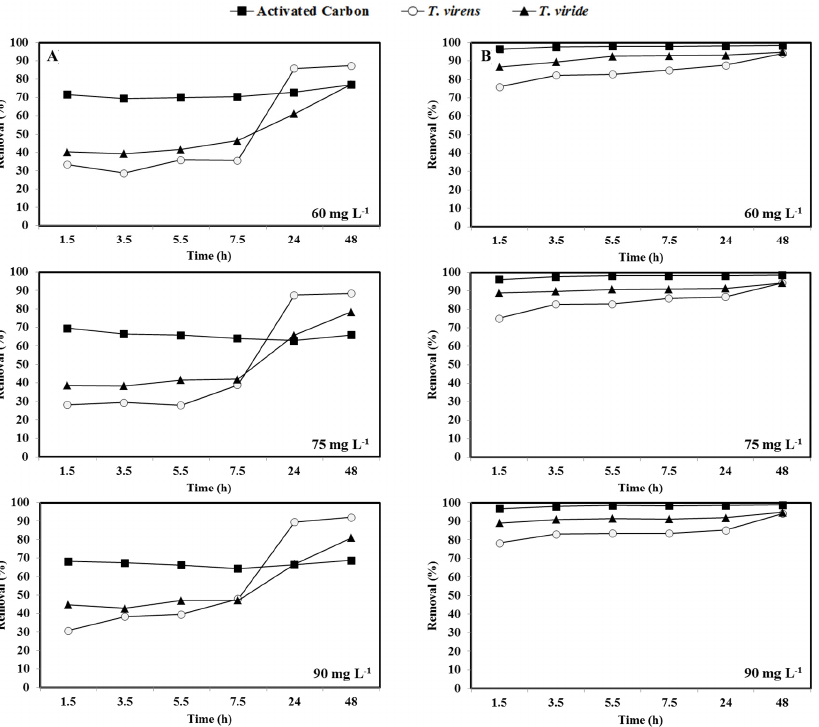
Figure 4. Removal efficiency of Congo red (row A ) and malachite green (row B ) (60, 75, and 90 mg L − 1 ) by activated carbon and fungal dry biomass of T. virens and T. viride . On the other hand, after 24 h, the dry biomass of both Trichoderma species showed higher CR removal capacity than activated carbon (Figure 4A). In addition, the CR re- moval obtained by the dry biomass of T. virens (88%) was higher than that reported for the fungus Aspergillus niger (72%) [73]. In contrast, MG removal by the dry biomass of both fungi was lower than that observed by activated carbon during the first 24 h, alt- hough, at 48 h, the removal of MG by the dry fungal biomass was similar to that observed for activated carbon (Figure 4B). Equilibrium adsorptions data of CR and MG onto activated carbon and dry biomass of the two Trichoderma species were analyzed using the Freundlich (Equation (2)) and Langmuir (Equation (3)) adsorption isotherms. The isothermal plots were found to be lin- ear, and the linear correlation coefficients were slightly higher for the Langmuir model (Figure 5); all the calculated isotherm model parameters are given in Table 2.